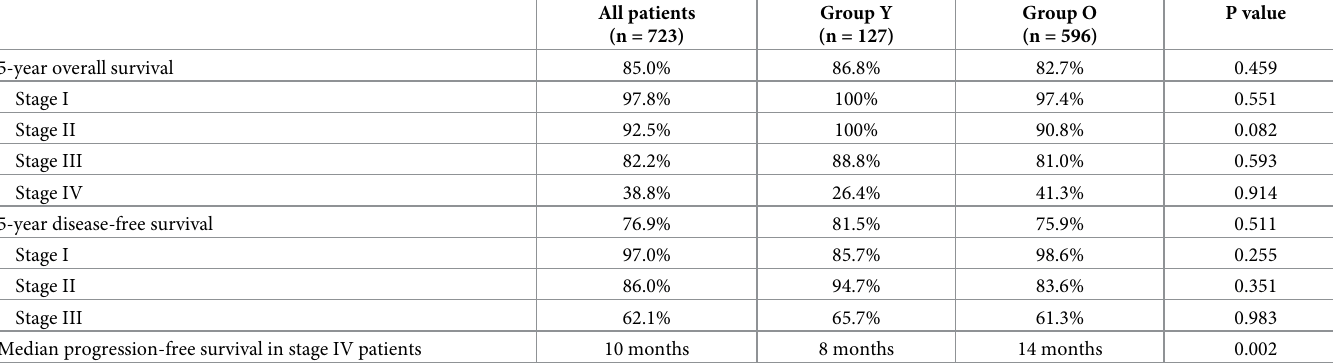
Table 2. Comparison of overall and disease-free survival in Groups Y and O with colorectal